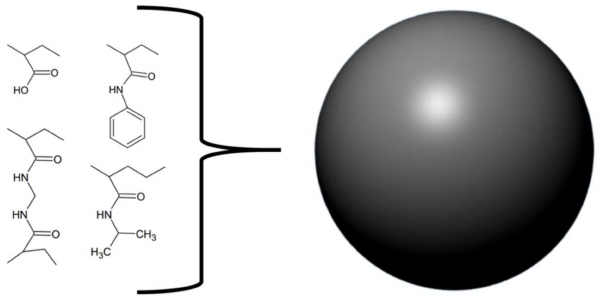
Figure 5. Schematic overview of the molecular components used by O’Brien et al. [46] to assemble the